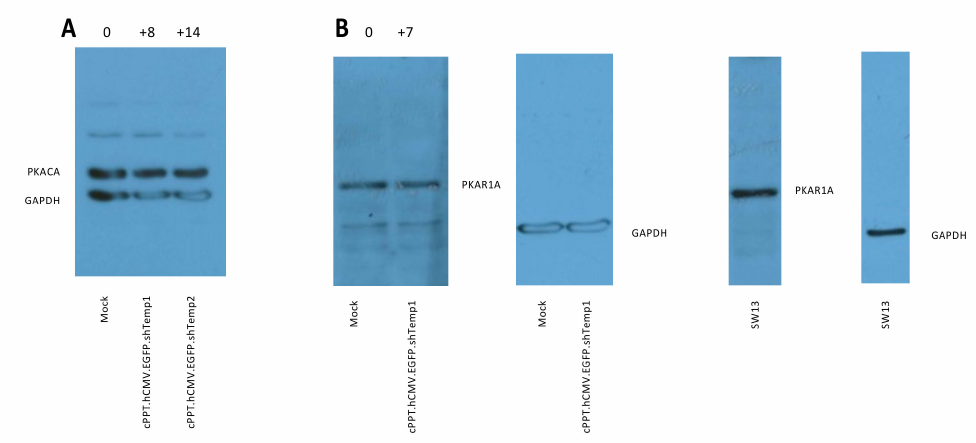
Figure 3. Western blot analysis of ( A ) PKA catalytic subunit in U87 cells 6 days after transduction; R2A silencing is shown in Supplementary Figure S1. ( B ) PKA R1A in U87 cells 33 days after transduction, same experiment as Figure 2D; SW13 cells are shown as a positive control for PKA R1A expression. The percentage of change relative to mock is shown above silenced